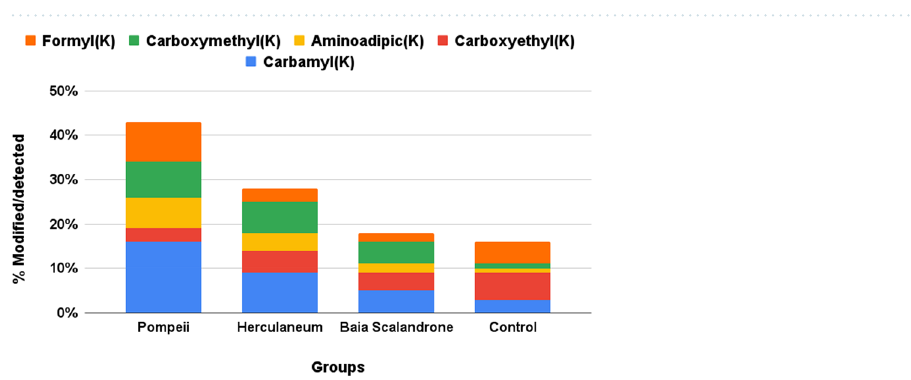
Figure 4. Extent of modified lysine residues, reported as percentage of modified over detected (modified plus unmodified)